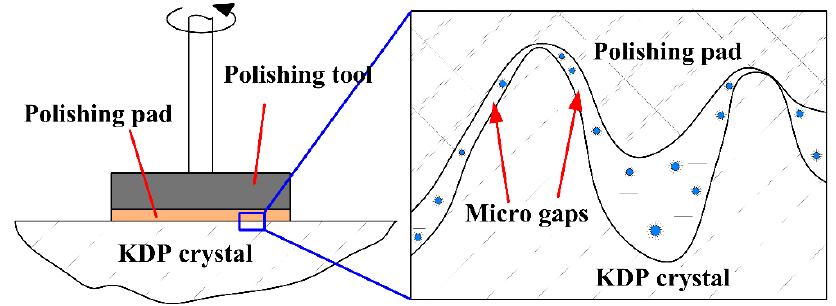
Figure 5. Illustration of micro gaps between polishing pad and KDP crystal.